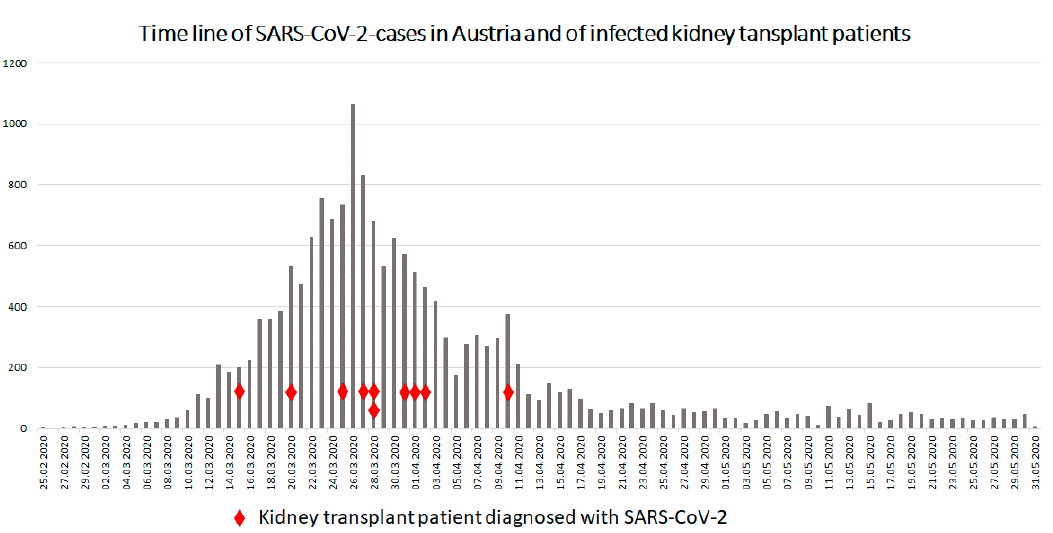
Figure 3. Daily timeline of new SARS-CoV-2 cases in Austria and time of occurrence of SARS-CoV-2 infection in the 10 affected kidney transplant recipients (Source: BMSGPK, Österreichisches COVID ‐ 19 Open Data Informationsportal (https://www.data.gv.at/covid ‐ 19; accessed on 7 August 2020) and Austrian Dialysis and Transplant Registry).